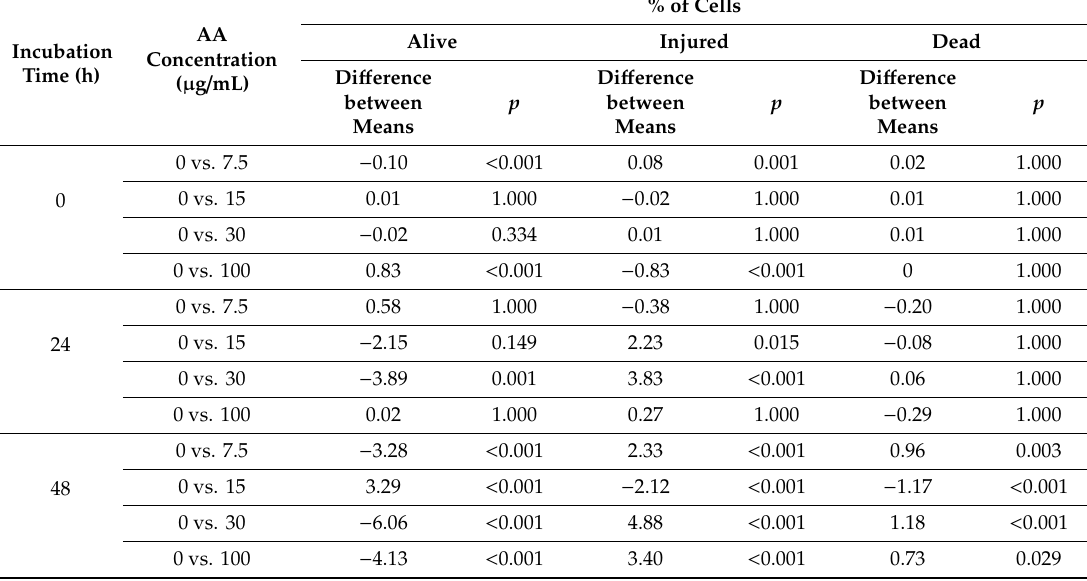
Table 5. The interaction e ff ect of incubation time and concentration of acrylamide on the viability of Lactobacillus acidophilus LA-5 (Bonferroni